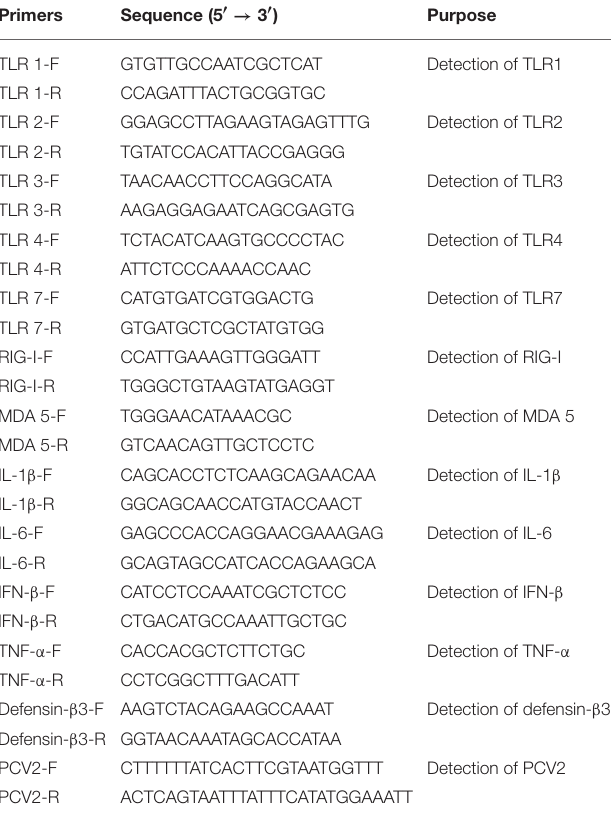
TABLE 1 | Primers used for PCR in this study.